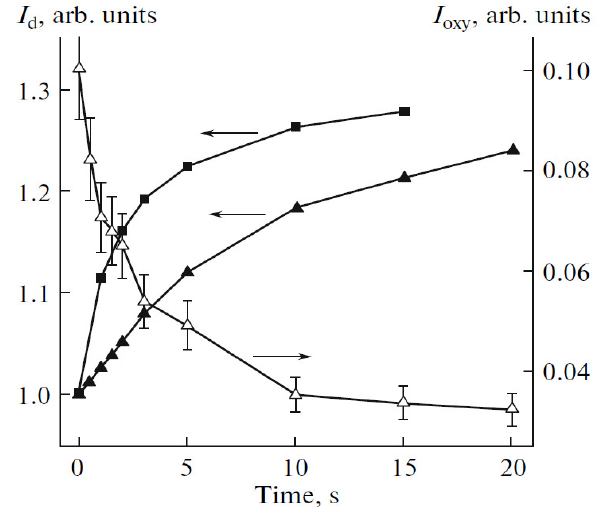
Figure 31. Dependences of the of (1) O 2 luminescence intensity, I oxy , (open triangles) and defect-related PL, I d , for initial por-Si (solid triangles) and por-Si powder (solid squares) for the photoexcitation time of por-Si powder in oxygen atmosphere at P ox = 1 bar. E exc = 2.33 eV, I exc = 0.1 W / cm 2 , T = 300 K. (Reprinted from Reference [73] by permission from Springer Nature Customer Service Centre GmbH: Springer © 2010.)